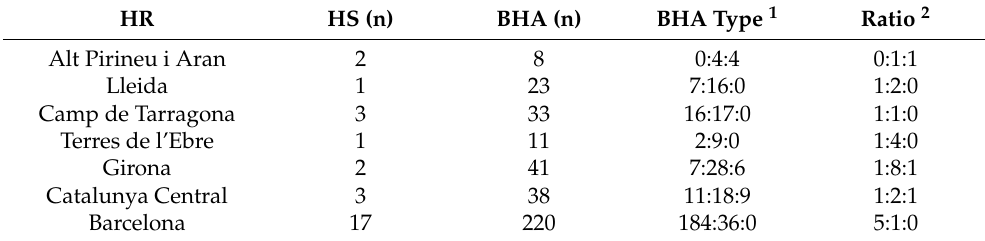
Table 1. Cluster analysis to obtain the proportion of pharmacies in each HR.